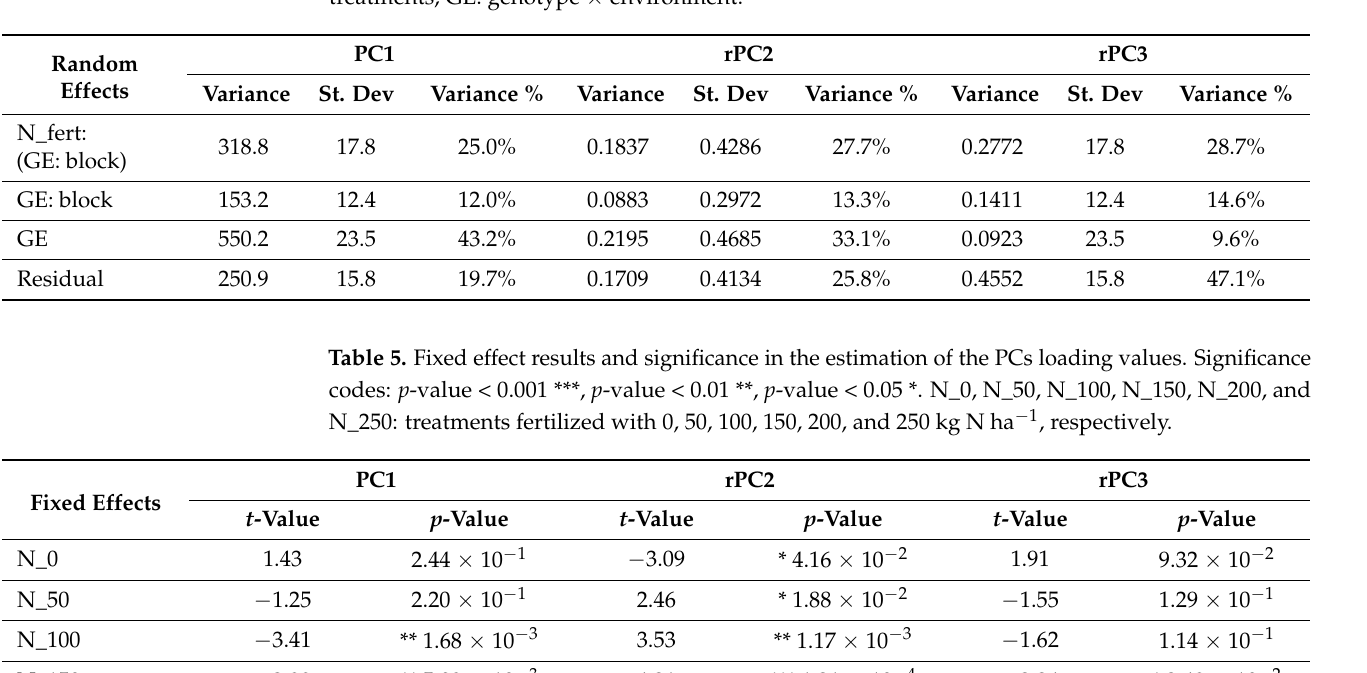
Table 4. Random effects variance, variance standard deviation, and percentage of total variance for each mixed linear model estimating PC1, rPC2, and rPC3, respectively. N_fert: N fertilization treatments; GE: genotype × environment.